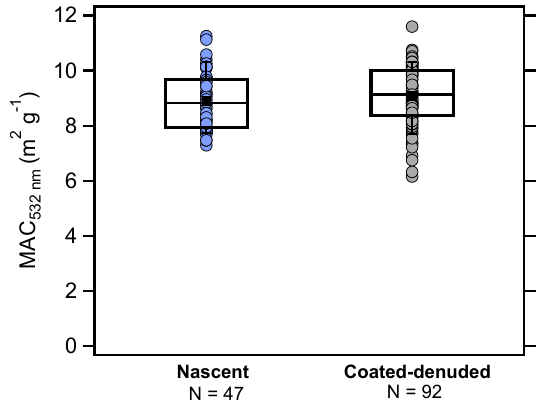
Figure 1. A comparison of methane-diffusion-flame-generated nascent (or nascent–denuded; blue circles) and coated–denuded (gray circles) mass absorption coefficients (MACs) at λ = 532nm for x > 0 . 90 for BC3, BC3 + , and BC4 experiments. Note that con- ditioning (and therefore the shape) of the soot does not affect the observed MACs. The box and whisker plots show the mean ( (cid:4) ), median (–), lower and upper quartile (boxes), and 9th and 91st per- centile